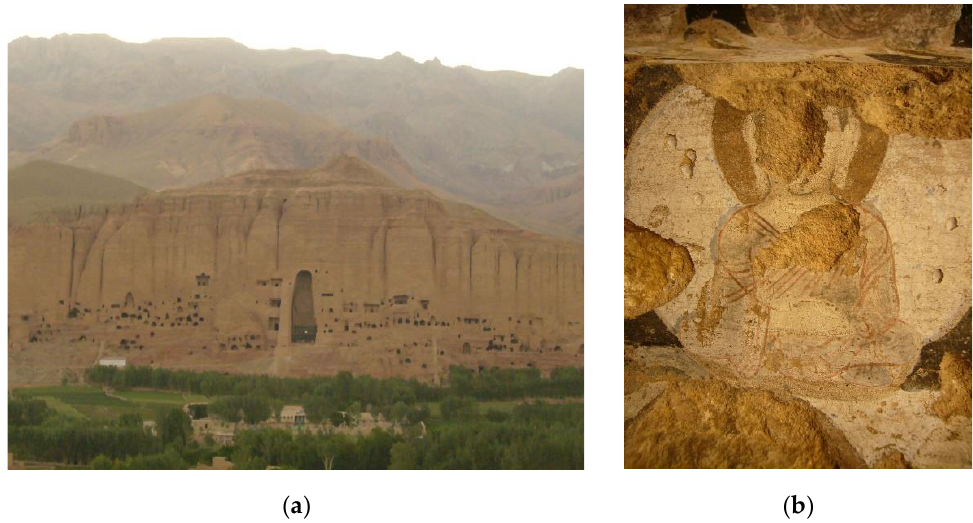
Figure 1. ( a ) EGB of Bamiyan, after demolishment in 2001. ( b ) Rare surviving wall painting of a partially vandalized seated Buddha, Foladi Cave 6. Black areas are the result of alteration in the green pigment, atacamite (photographed by Y. Taniguchi in 2007).